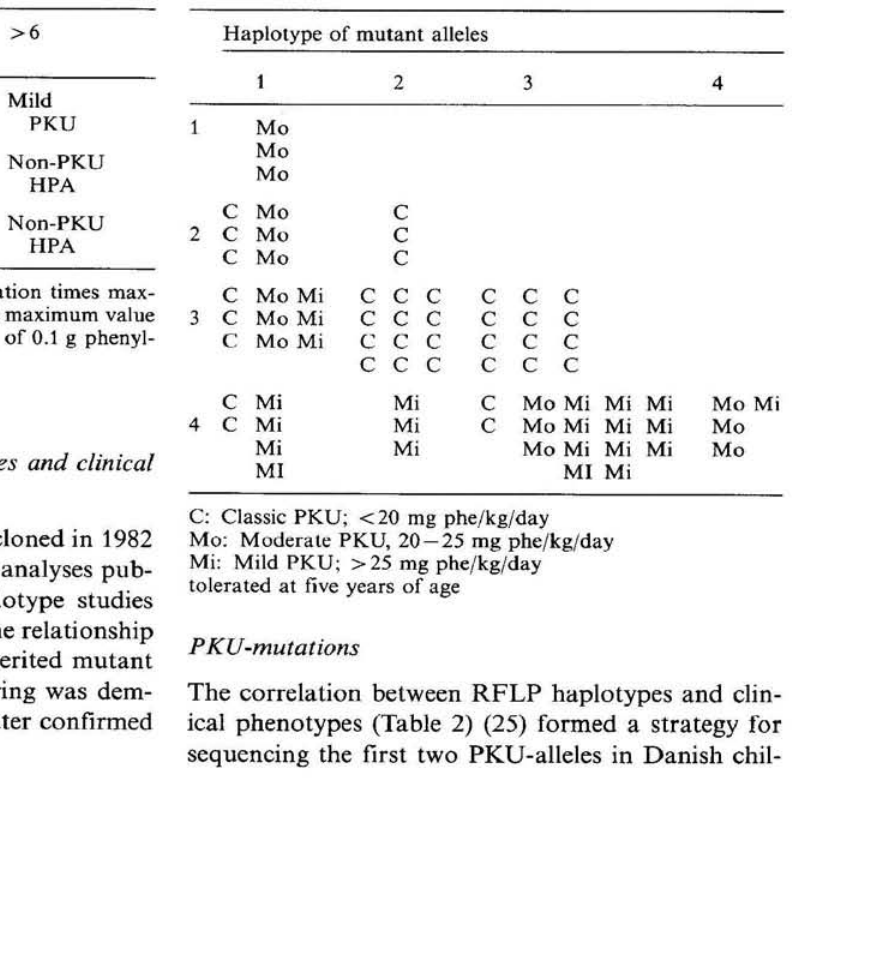
Figure 2. The segregation of the PKU alleles in a Danish family demonstrated by restriction fragment length polymorphisms at the phenylalanine hydroxylase locus obtained by the restriction enzyme Hinàlll and the phPAH247 cDNA probe. The PKU- allele segregates with the 4.2 kb fragment from the mother (M) and the father (F) to the PKU-child (P). The normal phenyl- alanine hydroxylase allele segregates with the 4.0 kb fragment from the parents to the unaffected sibling (S), who has inherited the two normal chromosomes of the family. Table 2. Haplotype of PKU alleles correlated to phenotypes in 74 Danish patients. Haplotype of mutant